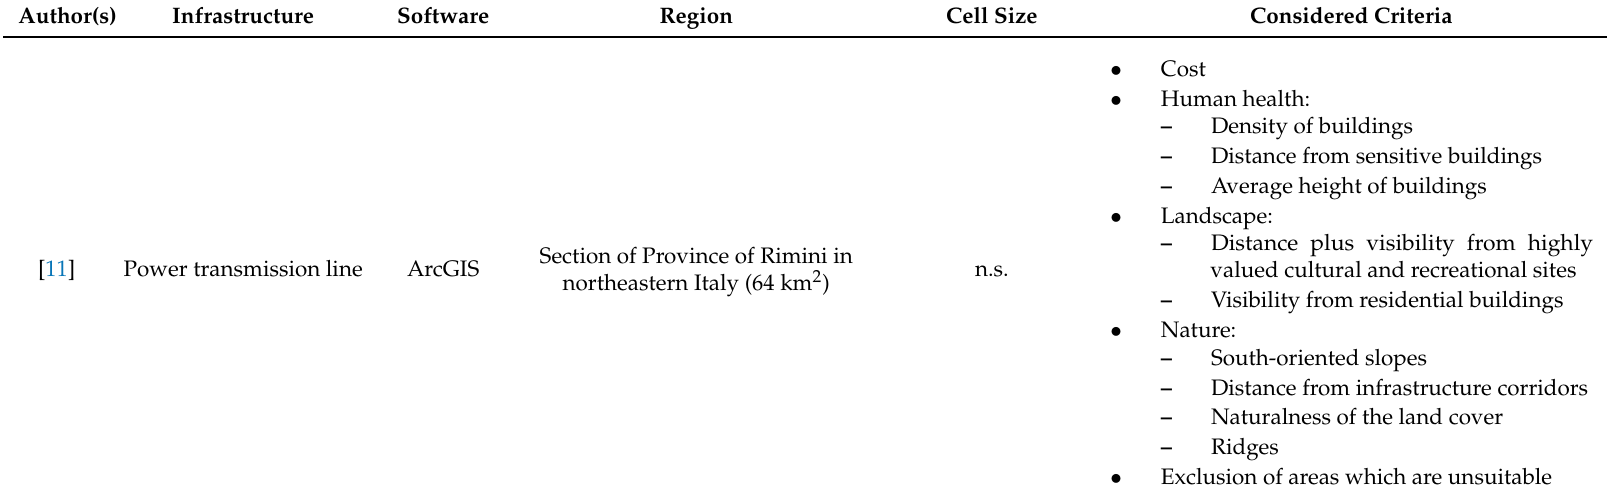
Table A2. Overview of the different studies which cope with generating and assessing least-cost paths for infrastructure route